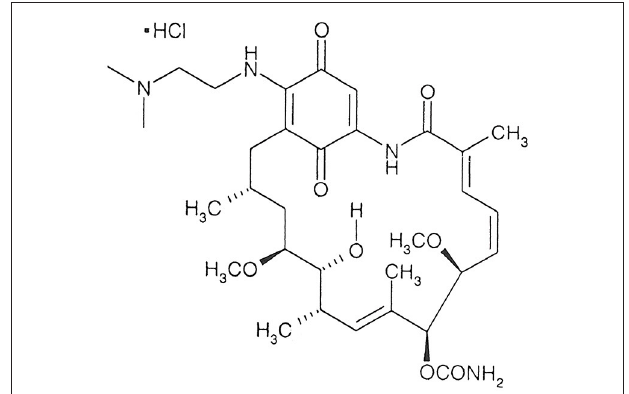
FIGURE 1 | Chemical structure of 17-DMAG. Extracted from 17-DMAG datasheet (LC Laboratories).